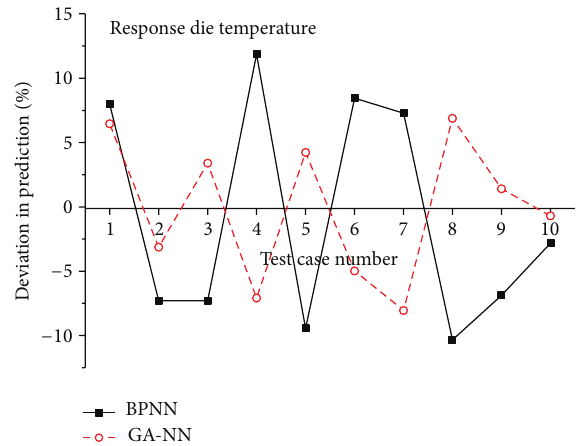
Figure 8: Comparison of two models in predicting the response die temperature.